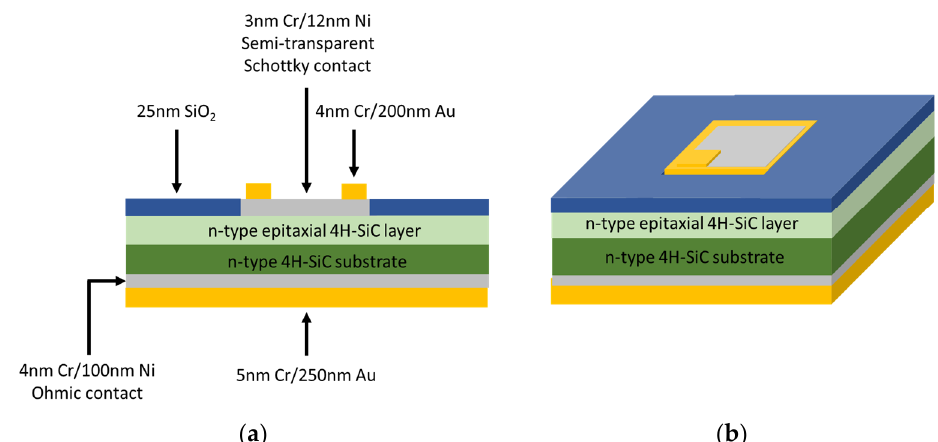
Figure 11. Semi-transparent Schottky diode. ( a ) Cross-section of semi-transparent SBD, and ( b ) semi-transparent Schottky contact and a gold bond pad (top view). Adapted from Ref. [11].